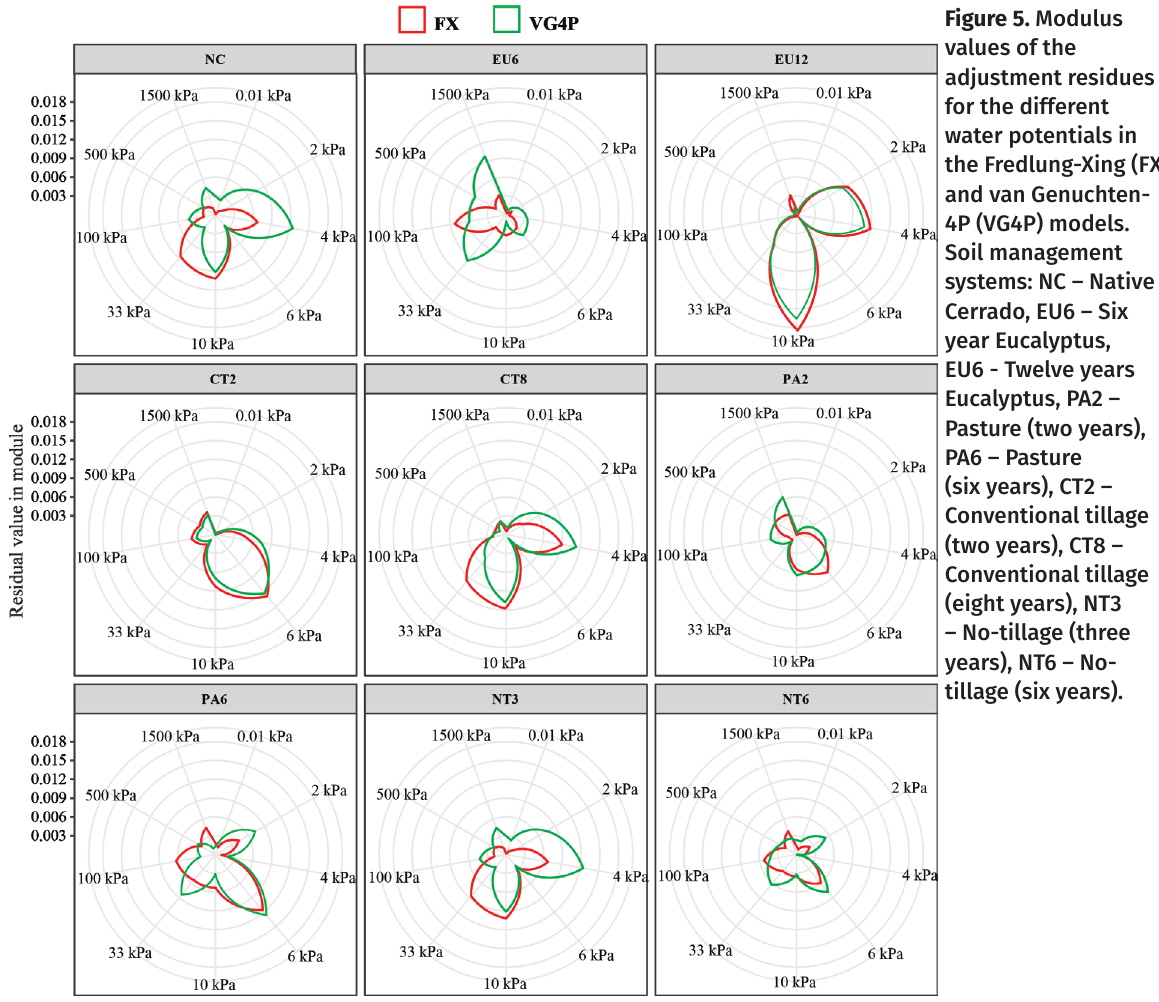
Figure 5. Modulus values of the adjustment residues for the different water potentials in the Fredlung-Xing (FX) and van Genuchten- 4P (VG4P)